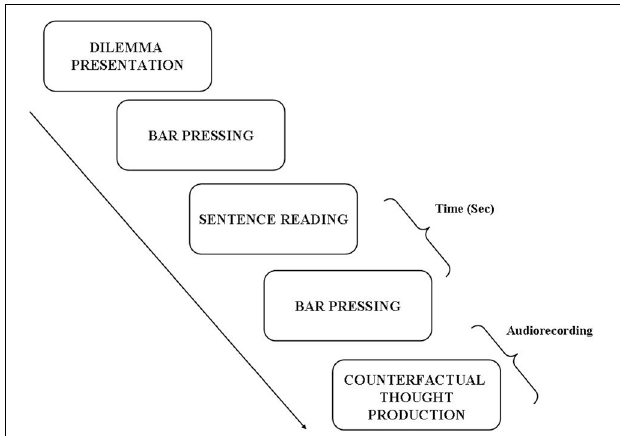
FIGURE 2 | Condition × Age interaction on Response time. (NM, Non Moral; MI, Moral Impersonal; MP, Moral personal. Young: 25 < x < 39 years; Adult: 40 < x < 55 years; Elderly: 56 < x < 70 years).